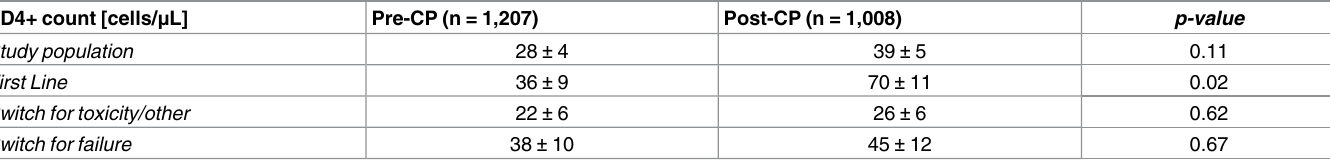
Table 5. Mean CD4+ change from baseline (12-month follow-up—baseline), Lombardy Region, Italy, comparing Pre-CP (2009–2010) and Post-CP